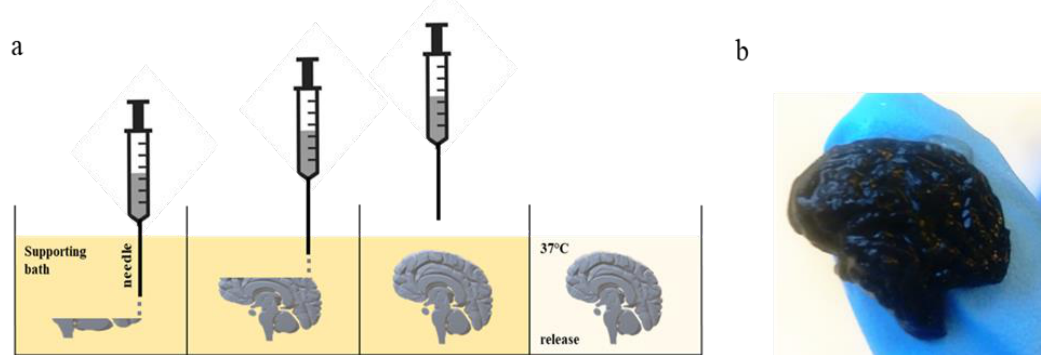
Figure 1. ( a ) Workflow of FRESH bioprinting technique. ( b ) Brain-like scaffold obtained by using cellulose-based bioink printed with Inkredible+.